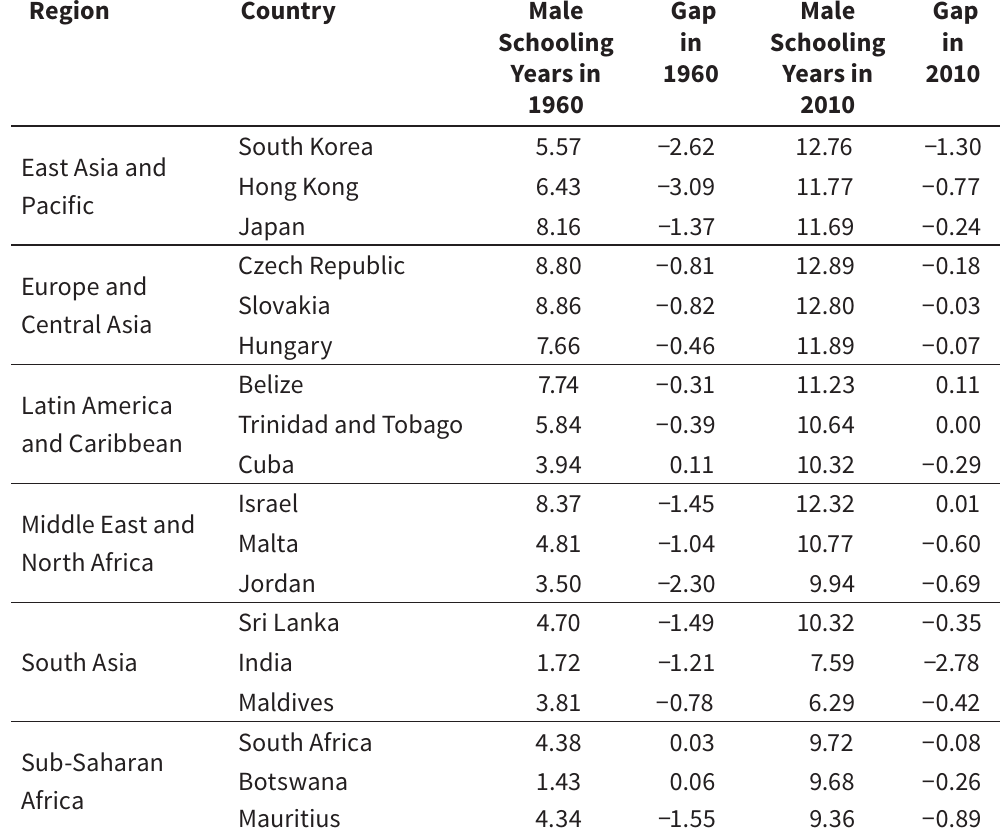
Table A3 Top Three Countries for Male Schooling Years by Region.